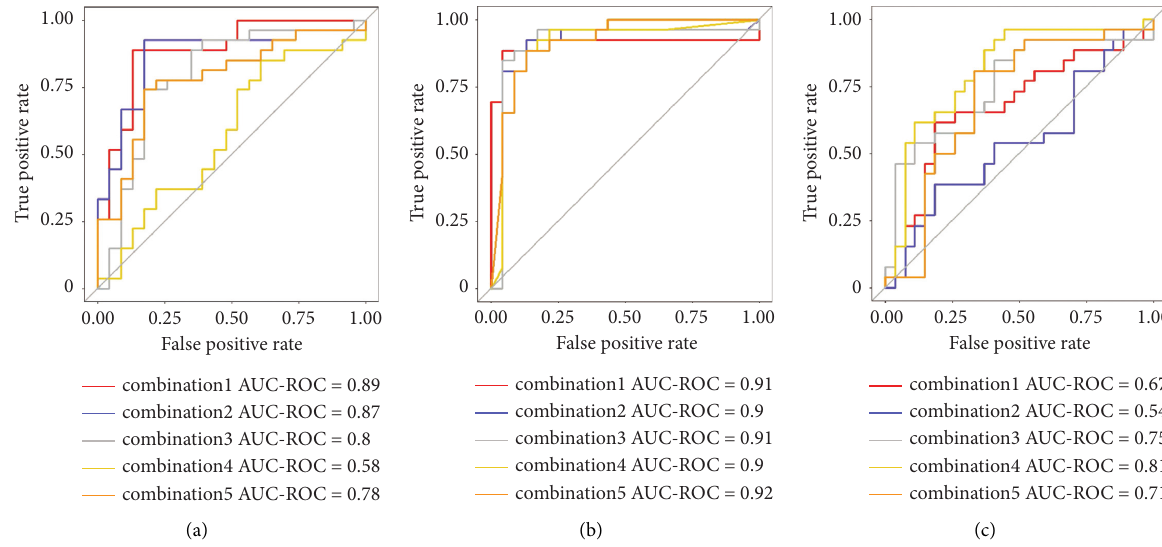
Figure 5: ROC curves of the metabolites (biomarker signature) results on plasma samples from all patients with pancreatic cancer versus healthy volunteers (a), from patients with diabetes mellitus versus healthy volunteers (b), and from patients with pancreatic cancer versus patients with diabetes mellitus (c). Models were tested through 5 repeated 5-fold cross-validation. AUC, area under the curve; combination1, model with top 5 metabolites selected from one-way ANOVA test; combination2, model with top 5 metabolites selected from Tukey’s honest significance test between diabetes mellitus patients and healthy volunteers; combination3, model with top 5 metabolites selected from Tukey’s honest significance test between pancreatic cancer patients and healthy volunteers; combination4, model with top 5 metabolites selected from Tukey’s honest significance test between pancreatic cancer patients and diabetes mellitus patients; and combination5, model with all the metabolites involved in previous 4